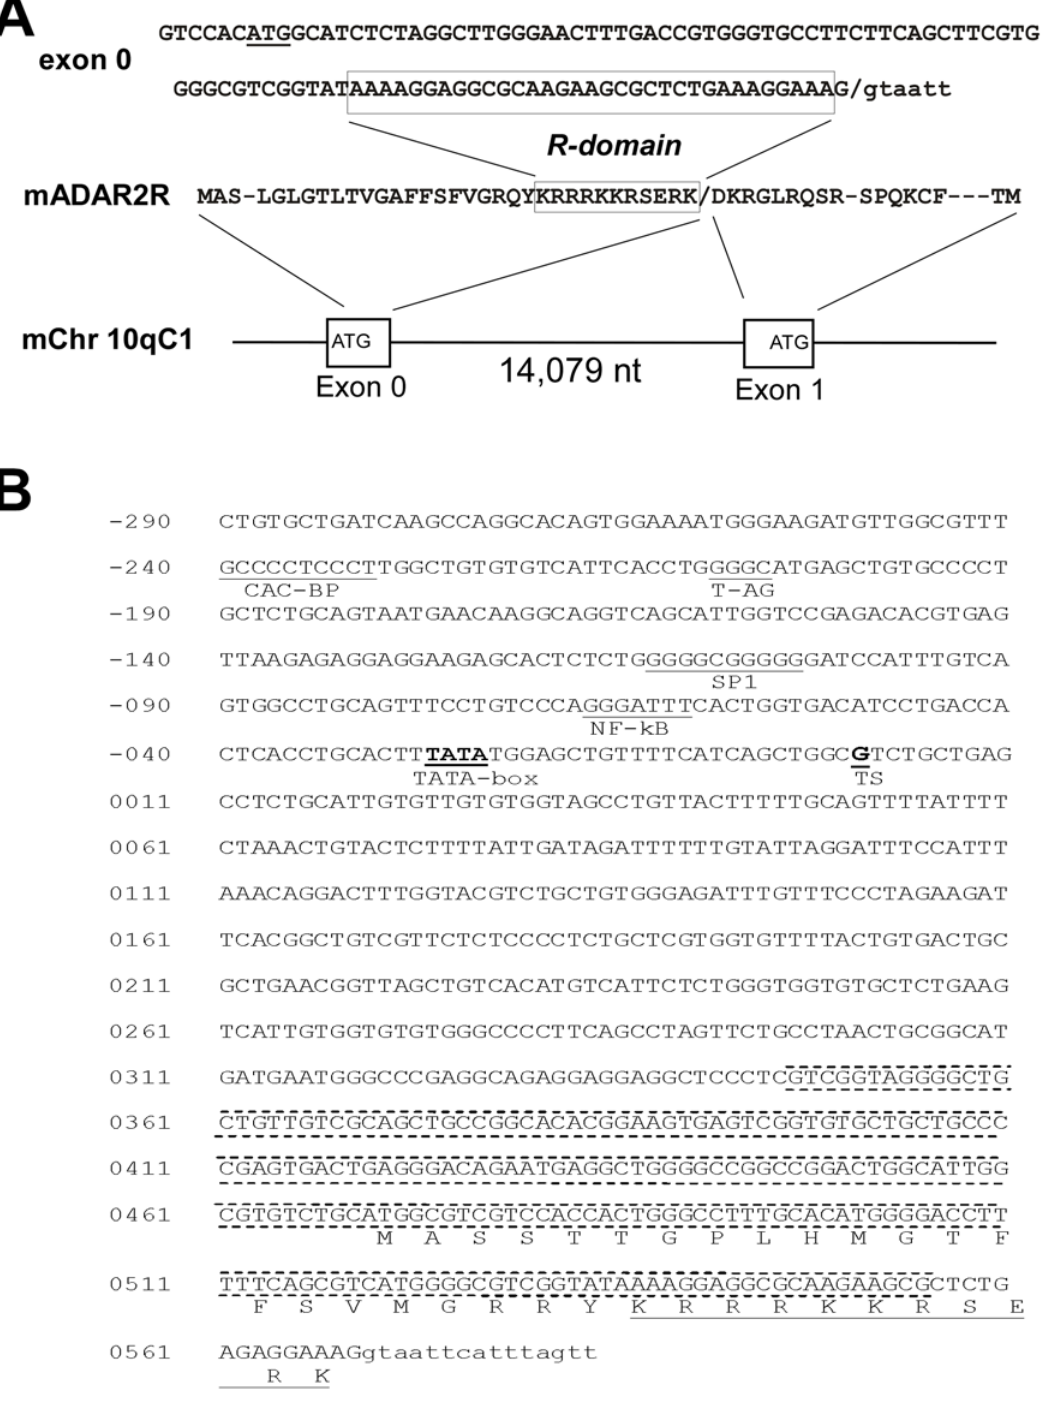
Figure 1. A new translated exon in ADAR2. A) Mouse exon 0 nucleotide, amino acid sequence and details of mAdar2 gene structure. The sequence of the R-domain is boxed, the translational start codon underlined. B) Human ADAR2 exon 0. The exon 0 sequence on human chromosome 21 is shown including translation and promoter sequences and transcriptional start site (TS) as predicted by ProScan. The CpG island is indicated by dotted lines above and below the sequence. Putative transcription factor binding sites for NF- k B, CAC-BP, T-AG, SP1 and a predicted TATA box sequence are marked. Intronic sequences are in small letters. doi:10.1371/journal.pone.0004225.g001 exon 0 in zebrafish could be an indication of evolutionary changes The ADAR3 genome architecture is strongly conserved to the in the regulation of A-to-I RNA editing that took place during the one of ADAR2 with respect to the splice donor site directly development of higher vertebrates. following the R-domain sequence.